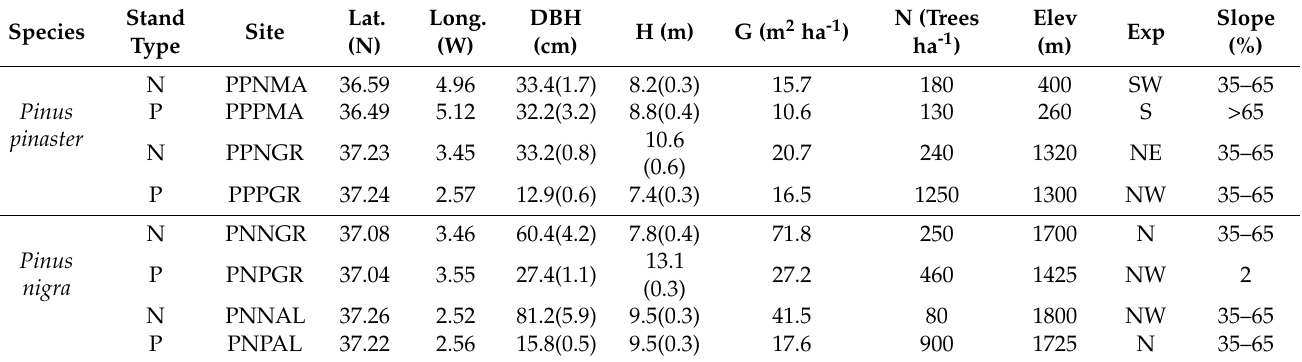
Table 1. Topographical and silvicultural characteristics of the Pinus pinaster and Pinus nigra forests sampled along an aridity gradient in southeastern Andaluc í a (Spain). Abbreviations: P, planted stands; F, forest (naturally regenerated stands); Sites, PPNMA, Pinus pinaster natural (M á laga); PPPMA, P. pinaster planted (M á laga); PPNGR, P. pinaster natural (Granada); PPPGR, P. pinaster planted (Granada); PNNGR, P. nigra natural (Granada); PNPGR, P. nigra planted (Granada); PNNAL, P. nigra natural (Almer í a) and PNPAL, P. nigra planted (Almer í a); DBH diameter at breast